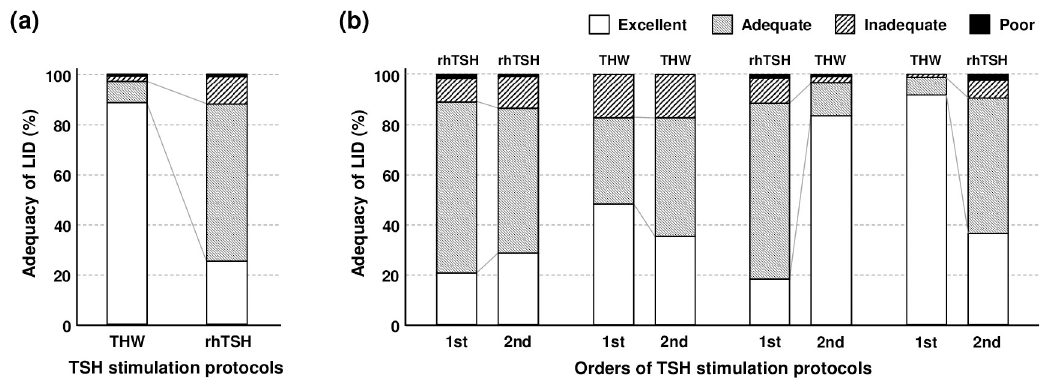
Fig 1. Adequacy of LID according to TSH stimulation protocols. In overall LID, THW group showed a higher proportion of ‘excellent’ adequacy than rhTSH group (a). In patients who underwent the first and second LID during the study period, the proportion of ‘excellent’ adequacy was higher in THW cases regardless of the order of protocols (b).